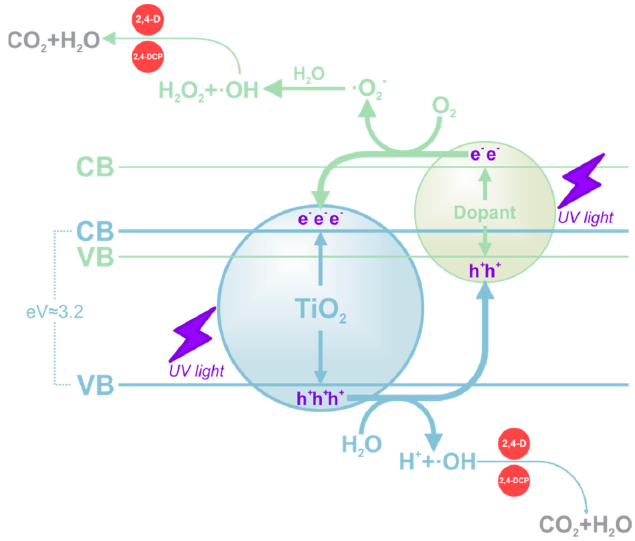
Figure 16. Photocatalytic mechanisms diagram for the deposited-TiO 2 .